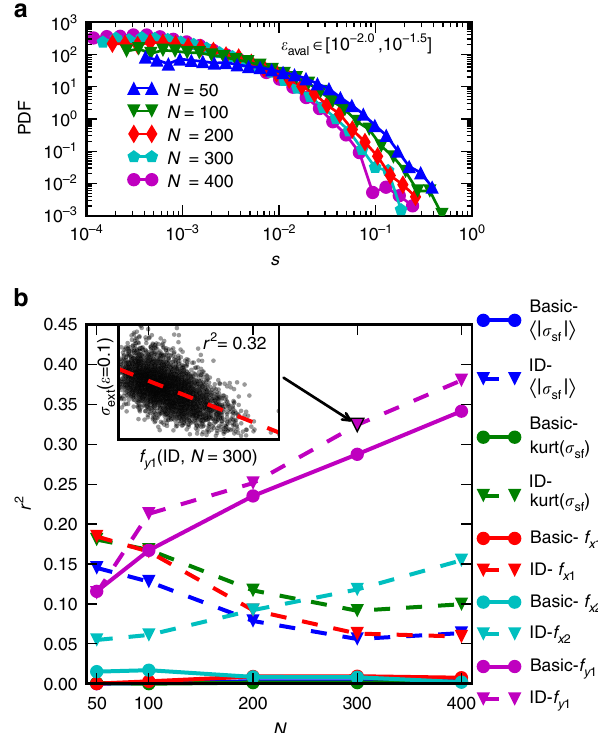
Fig. 5 Size effect of predictability. a The probability density of the strain avalanche sizes s in the basic system for bursts starting in a strain bin close to the start of the simulation. b r 2 of linear fi ts between chosen feature parameters (Methods) and the stress σ ext ( ε = 0.1) as a function of the system size (inset shows an example of such a fi t). Further information of the r 2 of single parameter fi ts for stresses at different strains is presented in Supplementary Fig. 9